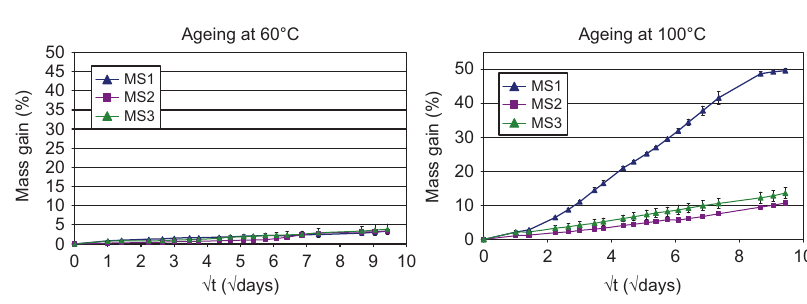
Figure 2 Gravimetry of syntactic foam with 55 % volume fraction GM during ageing.